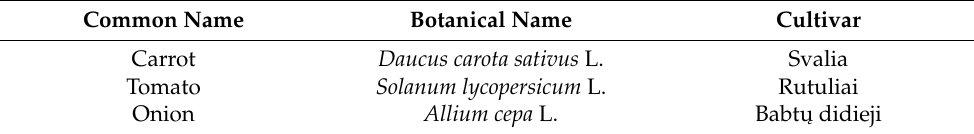
Table 1. Vegetable seeds used in the